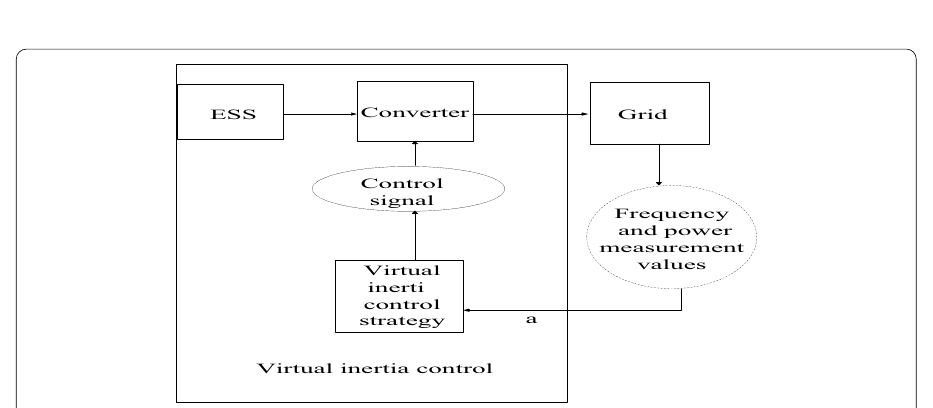
Fig. 4 Virtual inertia control system in the modern grid